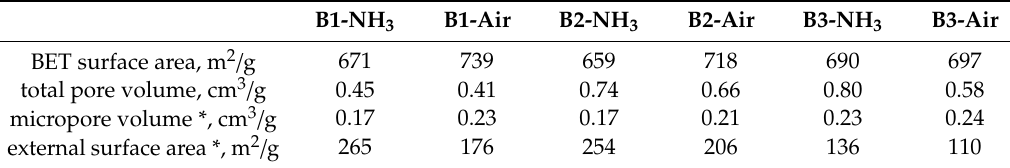
Table 2. Results of low ‐ temperature nitrogen adsorption and desorption isotherms.